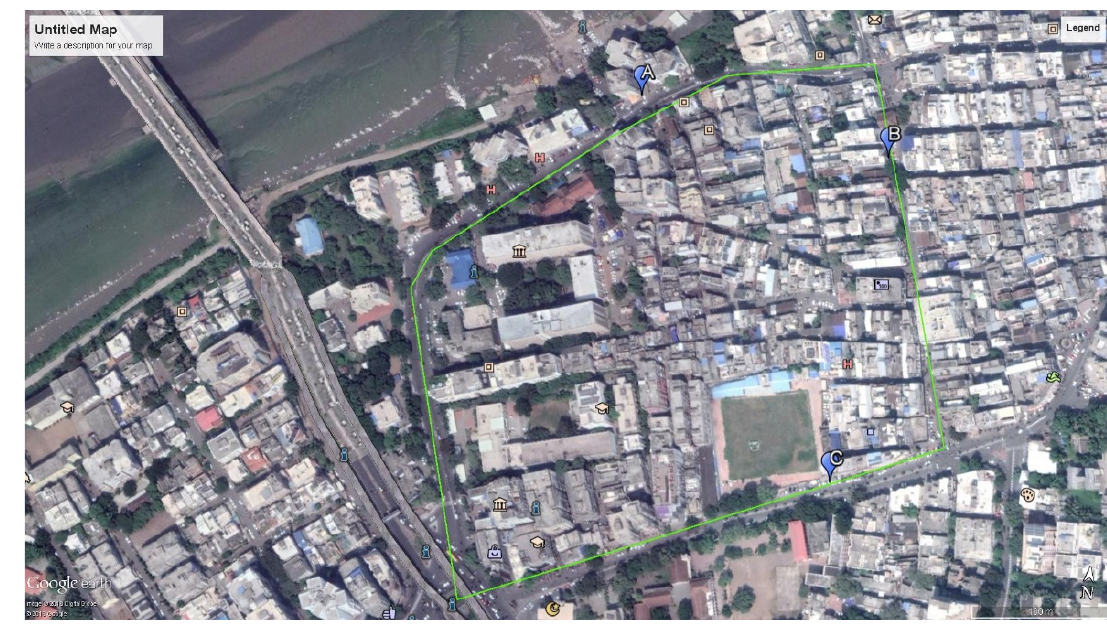
Figure 3: Map of Central zone of Surat city with monitoring locations